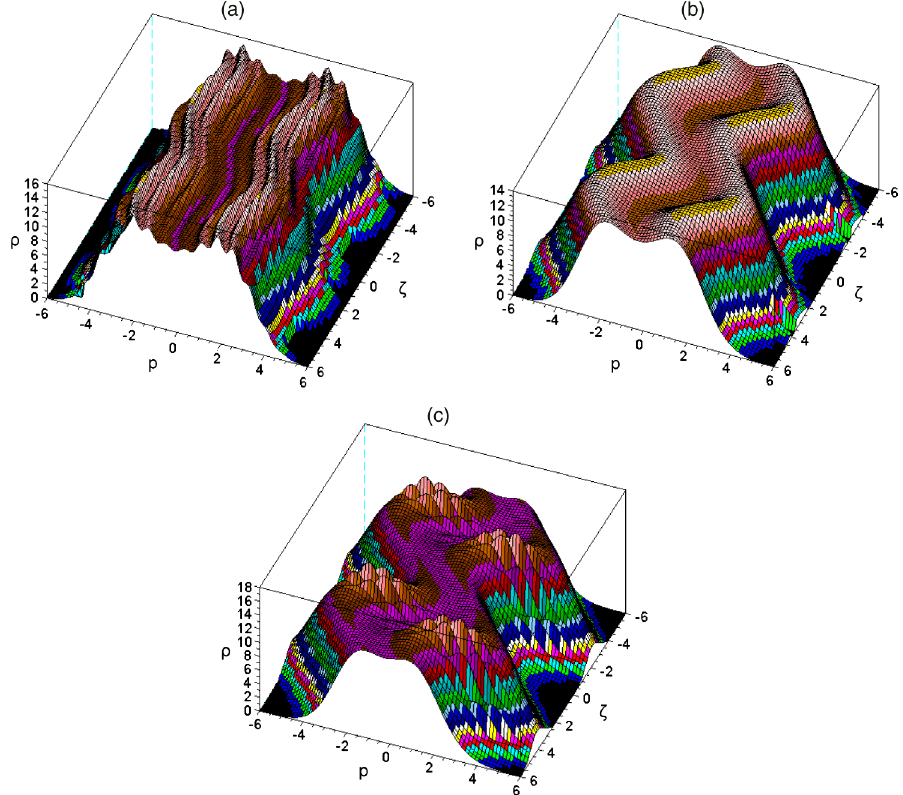
FIG. 3. Liouville distribution under the action of the Coulombian diffusion ( D ¼ 7 (cid:3) 10 (cid:1) 3 ) for different s values: (a) s ¼ 6 , (b) s ¼ 20 , (c) s ¼ 30 .